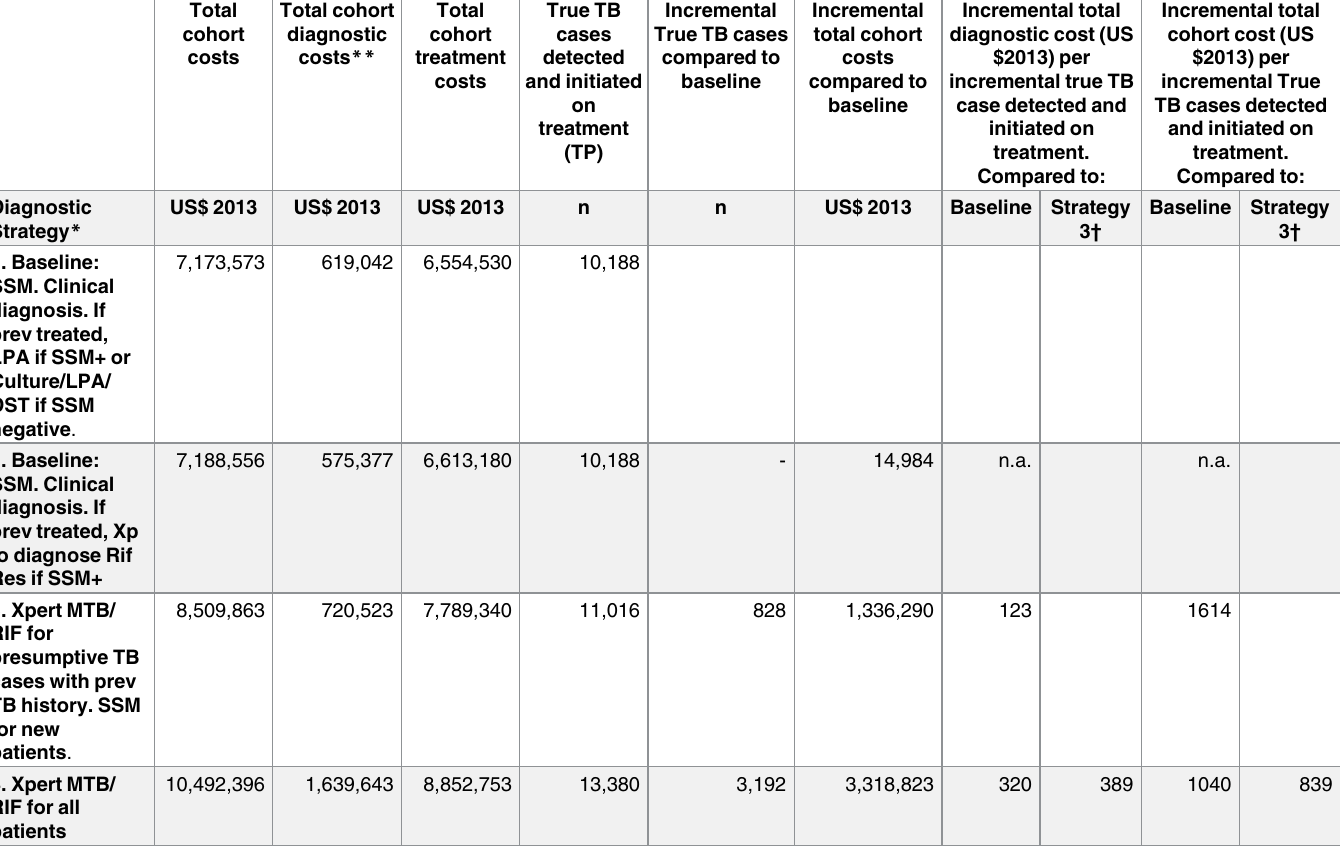
Table 4. Incremental cohort and diagnostic costs per true TB case detected and treated, for 4 diagnostic strategies (Cost in